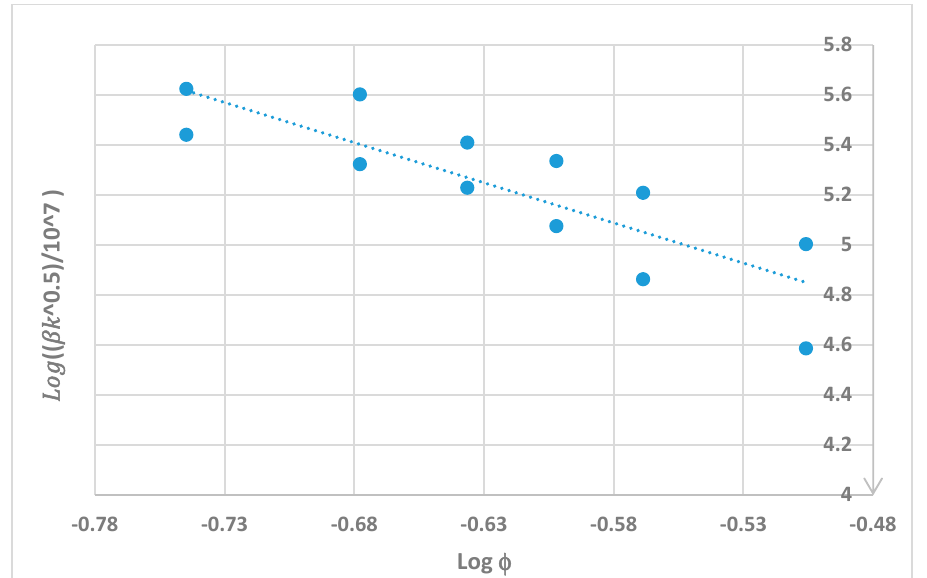
Figure 11. The non-Darcy coefficient for the seven samples resulted from two different air and water experiments.